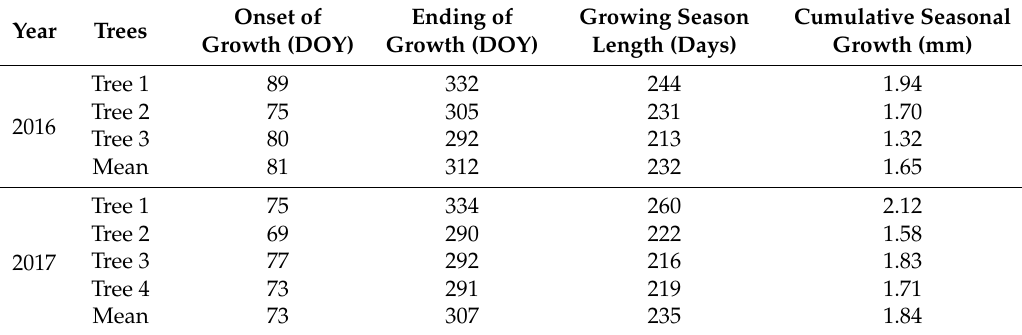
Table 1. Timing of growth onset and ending, and cumulative seasonal growth in 2016 and 2017. Onset and end of stem radial growth were estimated from the Gompertz function and given as day of year (DOY).